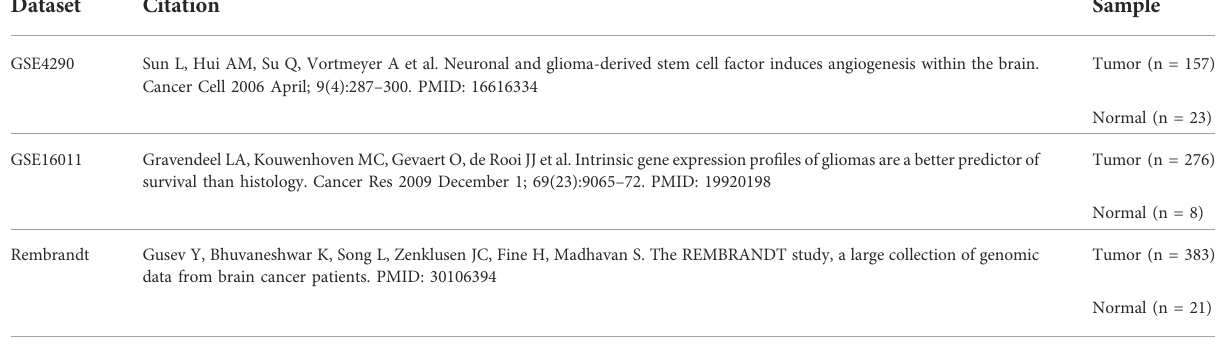
TABLE 1 Overview of the GEO and Rembrandt database.